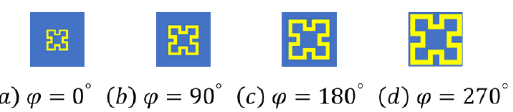
Figure 4. RIS artificial units based on Minkowski fractal structure.